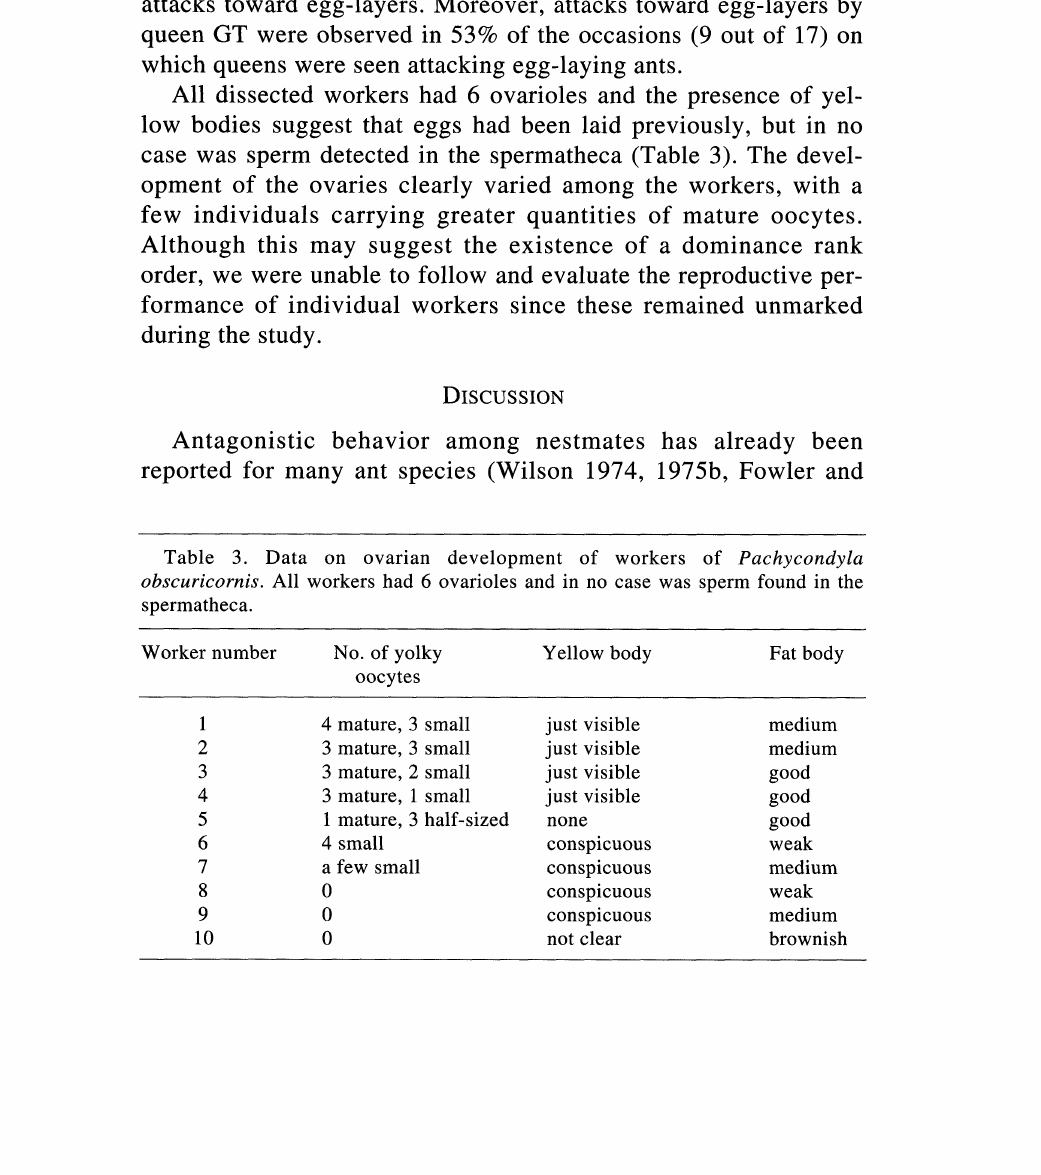
Table 3. Data on ovarian development of workers of Pachycondyla obscuricornis. All workers had 6 ovarioles and in no case was sperm found in the